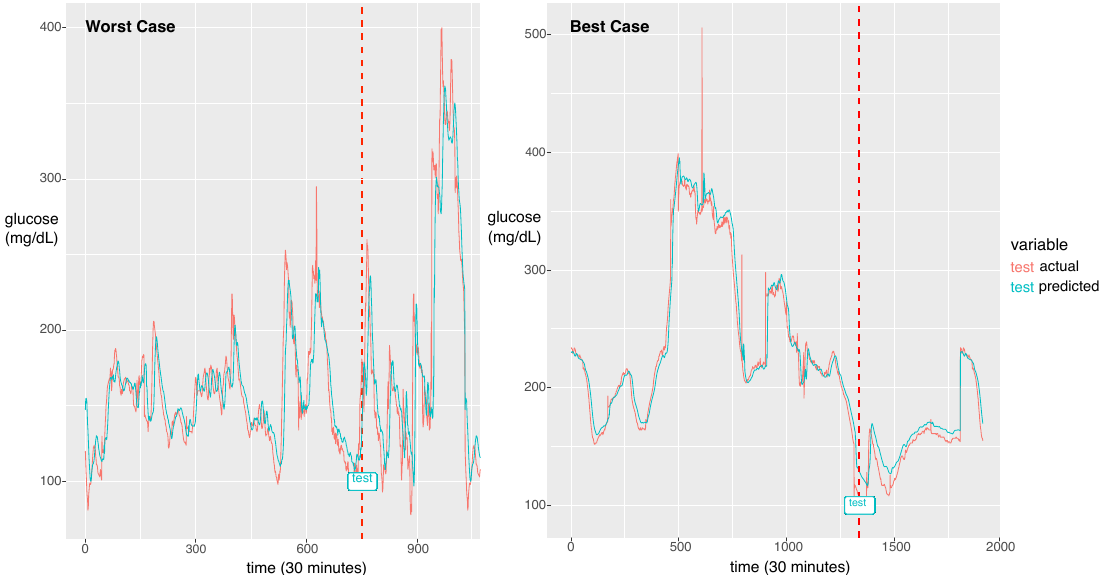
Figure 6. The worst case in the first panel and the best case in the second panel. The dotted line is the start time of testing. The red line is for the reference value and the green line is for the prediction